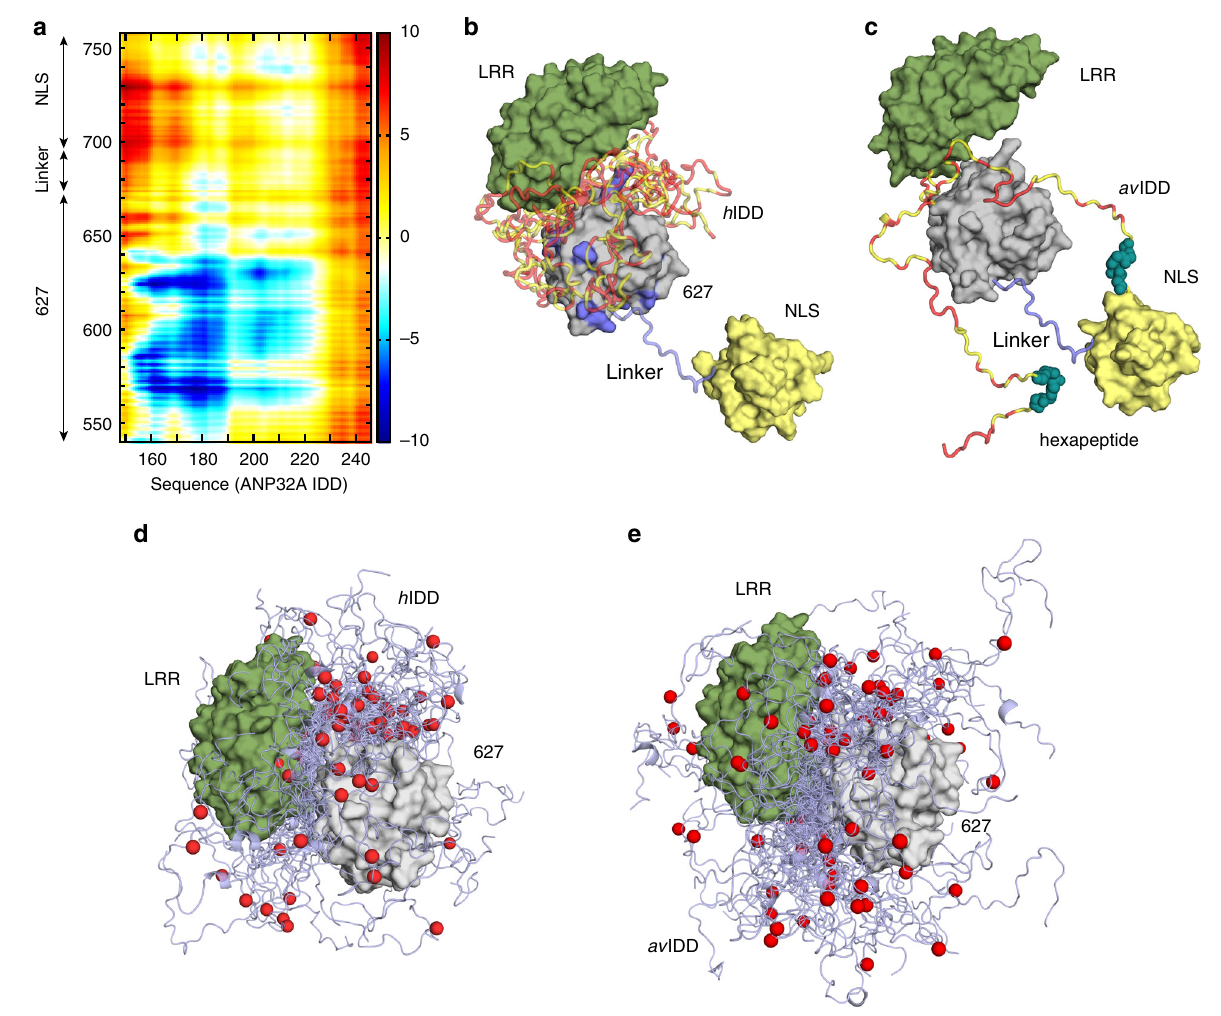
Fig. 4 Comparison of 627-NLS(K): h ANP32A and 627-NLS(E): av ANP32A interaction complexes. a Average distance difference matrix, showing the average difference ( d hh − d avav ) in distance between amino acid positions in the IDD of ANP32A ( x -axis) and the 627-NLS domains ( y -axis) over the two ensembles. The colour code shown on the right is measured in Å. b Representation of the key interactions between h ANP32A and 627-NLS(K). Polyvalent interactions between 627 and the IDD localise the disordered domain in the vicinity of the basic patch on the surface of 627 (see Fig. 3). The different IDD chains are shown to represent different binding modes and are truncated at residue 200 for clarity. Red positions in the IDD indicate the acidic sidechains. Note that this representation illustrates the tendency over the entire ensemble that is highly disperse (see d and e ). c Representation of the key interactions between av ANP32A and 627-NLS(E). In this case, the average distance between the IDD and the surface of 627 is larger, but in general closer to the NLS domain, in particular the hexapaptide of ANP32A, and the linker between 627 and NLS. The two IDD chains represent reduced polyvalency compared to h ANP32A and 627-NLS(K), and are again truncated at residue 200 for clarity. d Representative ensemble of conformations describing the conformational space sampled by the h ANP32A:627-NLS(K) complex. The NLS domain has been removed for clarity, and the IDD truncated at residue 210. The position of residue 190 is indicated as a red sphere. e Representative ensemble of conformations describing the conformational space sampled by the av ANP32A:627-NLS(E) complex. Representation as in d (Fig. 4b – e), as shown quantitatively in the average distance map (Fig. 4a), that identi fi es closer contacts in the 627-NLS(K): h ANP32A complex for residues 160, 180 and 205 with 570, 586 and 627, and closer contacts between the linker and NLS regions, and av ANP32A region 150 – 200 (Fig. 4a).